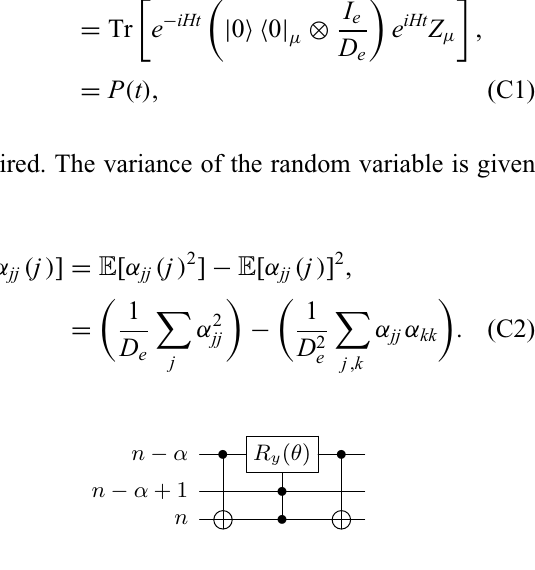
FIG. 18. A circuit that yields the unitary operator, which we . This operator acts trivially on all input states, refer to as W α n except those noted in Eq.